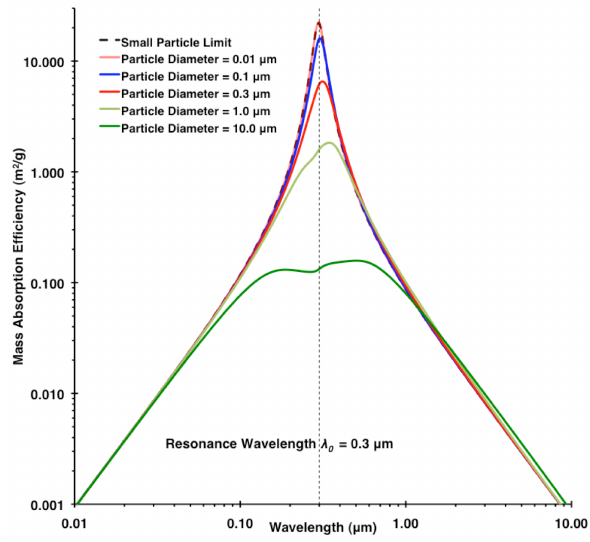
Fig. 7. Damped simple harmonic oscillator model wavelength de- pendence of the mass absorption efficiency ( E abs ; for a mass den- sity of 1gcm − 3 ) for fine particles (Eq. 12 and Fig. 6) and for spherical particles with particle diameter ranging from 0.01µm to 10µm from Mie theory calculations using the bulk refractive index (Eqs. 4a, b and Fig. 2).